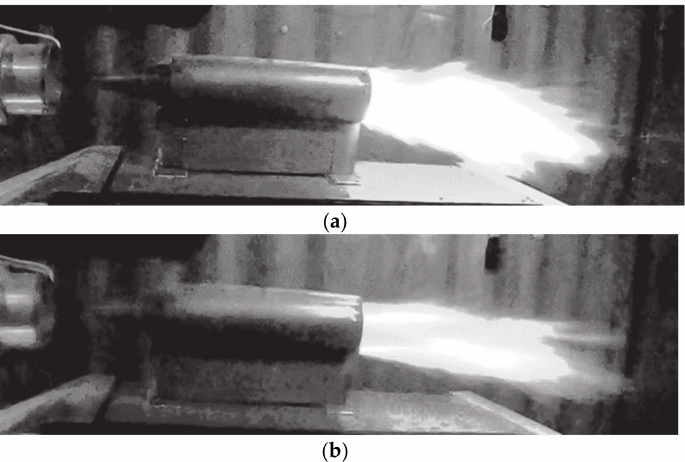
Figure 13. Frames of video recording of preliminary test fires of a modified dual-duct DR demonstra- tor at ( a ) M = 2 and ( b ) M = 1.5 with ethylene as a